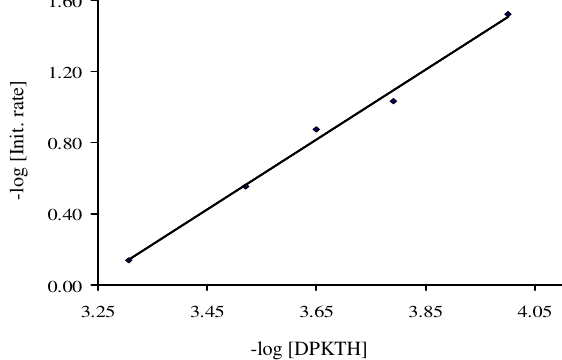
Figure 7. Plot of log [Initial rate] vs . log [DPKTH] at λ 1 x 10 -4 M, [Cysteine] = 2 x 10 -4 M, [DPKTH] = 0.5–2 x 10 -4 M, 10% ethanol and pH = 5